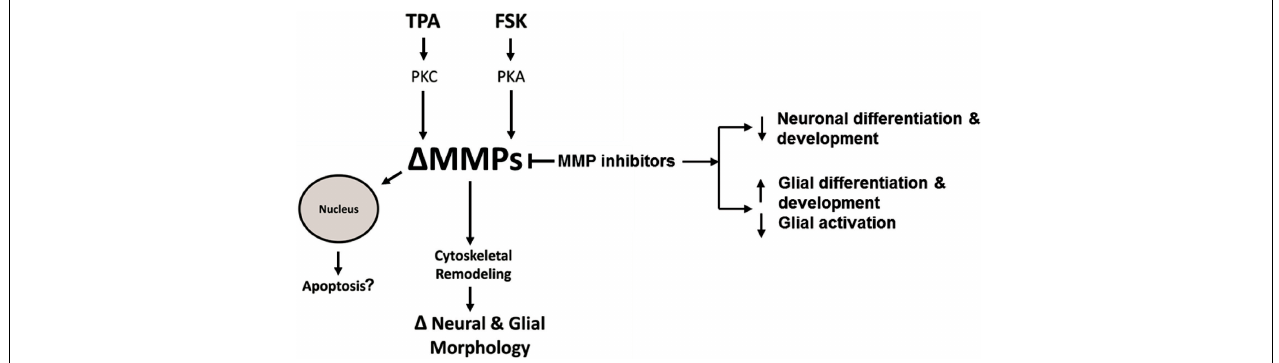
FIGURE 10 | Hypothetical intracellular MMP Signaling Pathways. Hypothetical pathways that alter intracellular MMPs resulting in neural and glial cell morphology changes or apoptosis. TPA activates PKC signaling resulting in altered MMP activity or expression ( (cid:49) MMPs). FSK activates PKA signaling resulting in (cid:49) MMPs. Intracellular (cid:49) MMPs promote cytoskeletal remodeling, changing neural and glial cell morphology ( (cid:49) Neural & Glial Morphology). MMP inhibitors modulate MMP activity resulting in decreased neuronal growth and differentiation while increasing glial growth and differentiation. MMP inhibition, on the other hand, can inhibit glial activation. (cid:49) MMPs can enhance MMP nuclear localization leading to possible